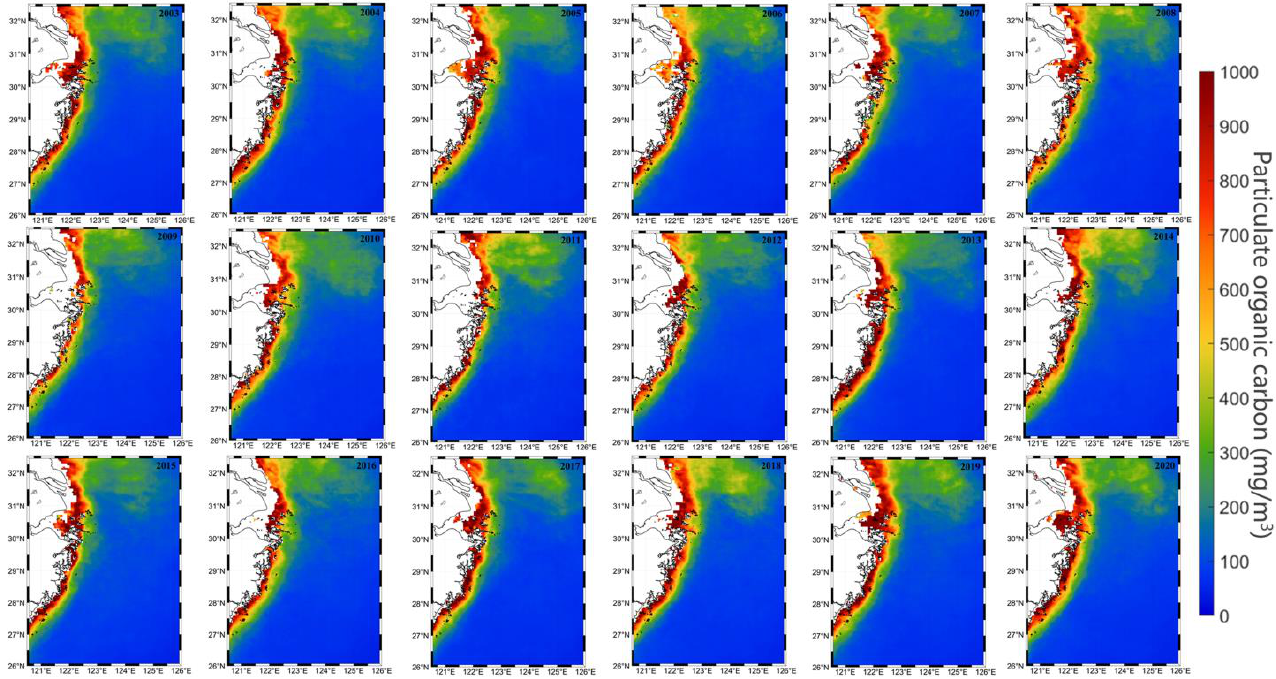
Figure 5. Long-term series distribution of annual mean particulate organic carbon concentration in surface seawater of the East China Sea from 2003 to 2020.